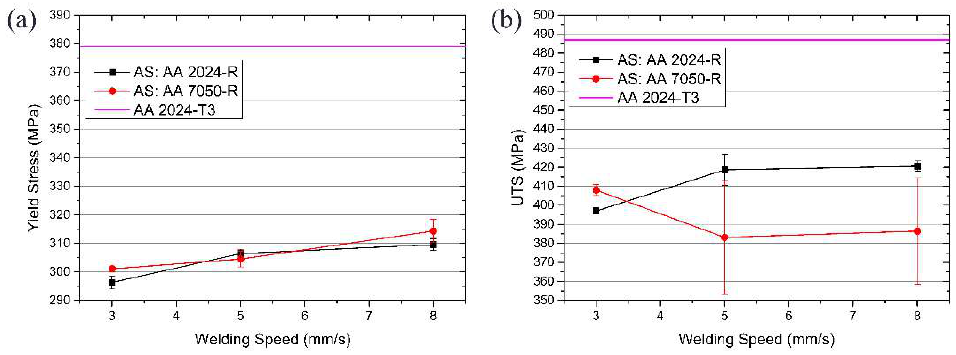
Figure 12. Variation in the ( a ) Yield Stress (YS) and ( b ) UTS with changing WS and the material position.